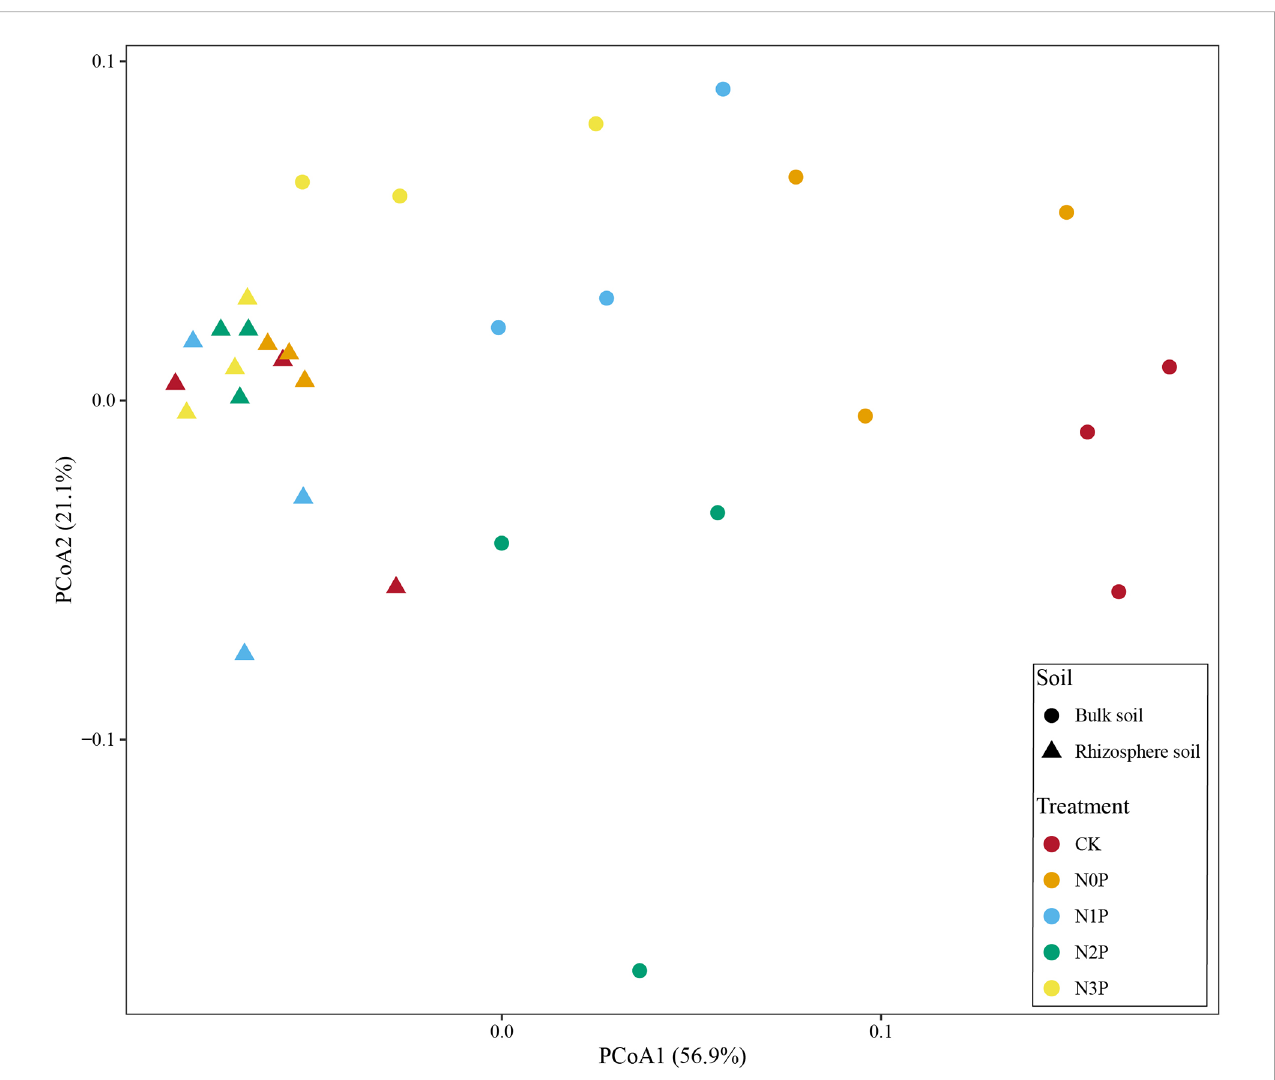
FIGURE 1 PCoA analysis of the bacterial community structure in the rhizosphere and bulk soil of S. salsa at different N-P addition ratio